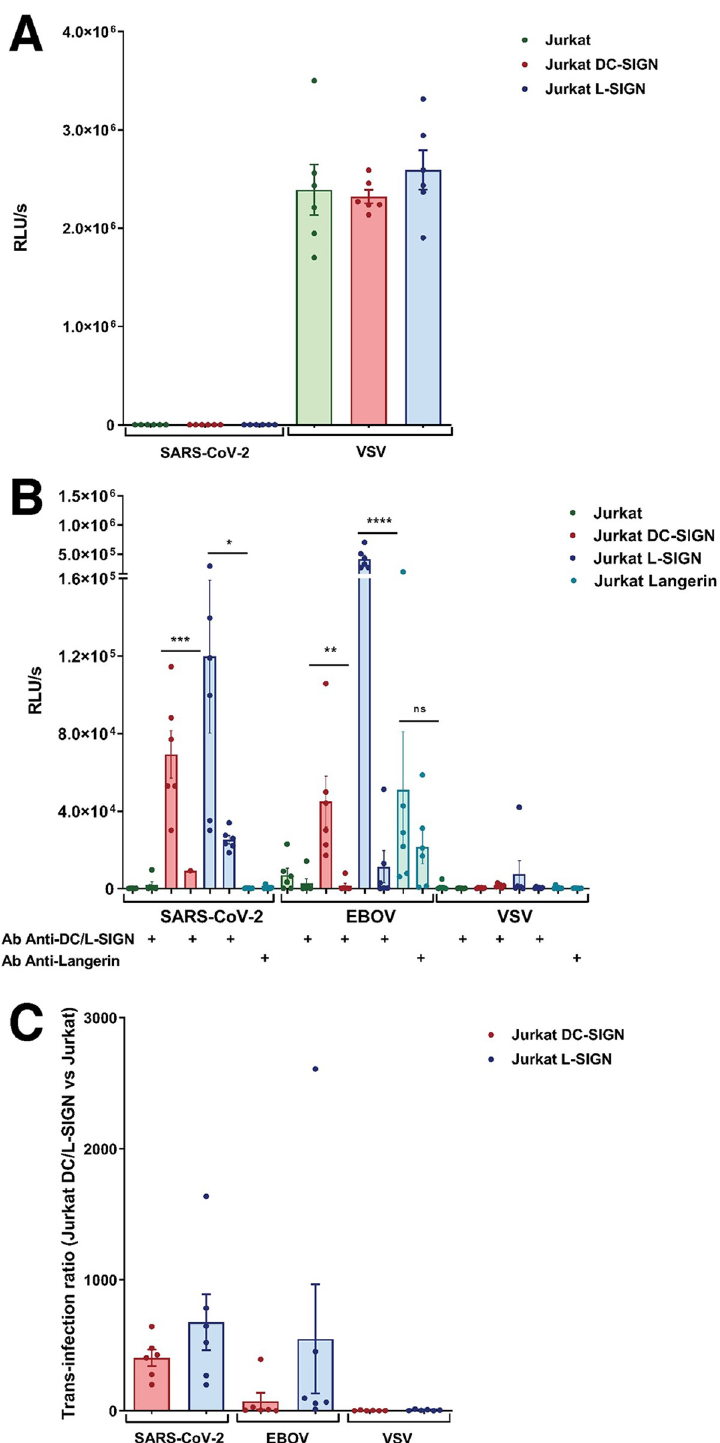
Fig 5. Impact of DC/L SIGN and Langerin in cis- and trans-infection of VSV/SARS-CoV-2. ( A) Direct infection of Jurkat, Jurkat DC-SIGN and Jurkat L-SIGN with SARS-CoV-2 and VSV pseudovirus. ( B) Trans-infection using Jurkat cell with or without CLRs DC-SIGN, L-SIGN and Langerin with SARS-CoV-2, EBOV and VSV pseudovirions on Vero E6 cells. As a control of inhibition of trans-infection mediated by CLRs, Ab specifically directed toward the corresponding CLR were used. ( C) Trans-infection ratio of Jurkat DC-SIGN or Jurkat L-SIGN versus Jurkat cells with